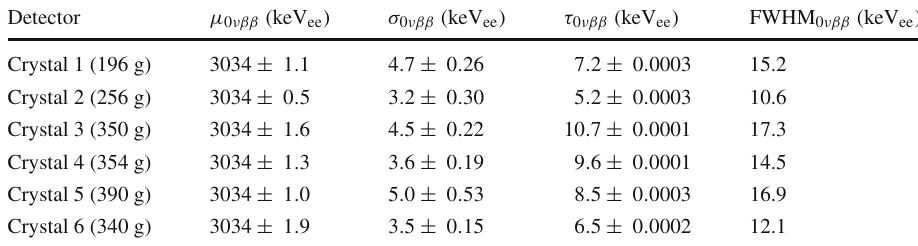
response function (Eq. (8)) at the 0 νββ decay Q -value for each detector